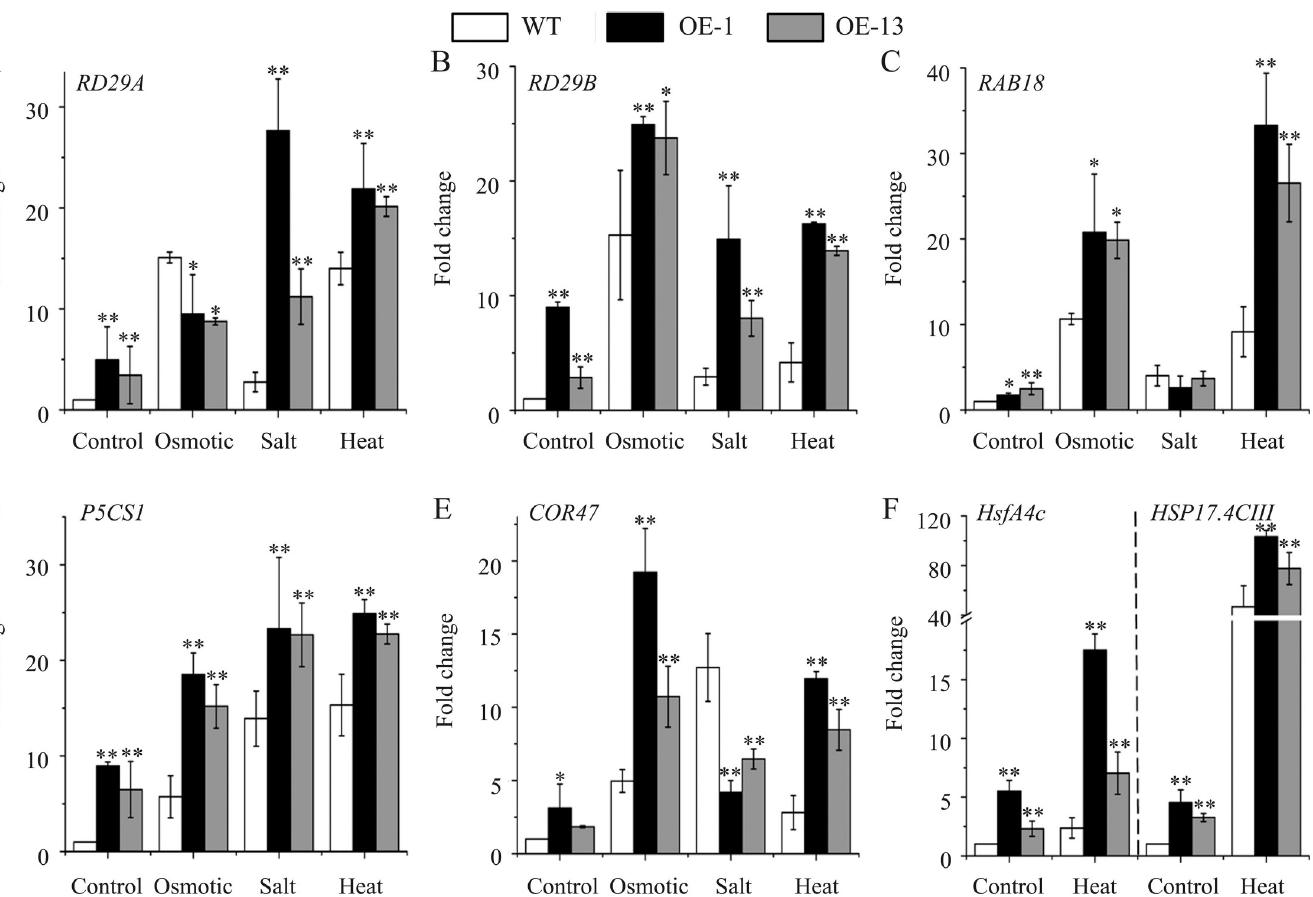
Fig 10. Transcript levels of seven stress-inducible genes in AmDREB3 transgenic Arabidopsis. The transcript levels of seven stress-inducible genes in two-week-old seedlings were examined by RT-qPCR analysis. The seedlings were exposed to osmotic stress (350 mM mannitol), salt stress (175 mM NaCl), or heat stress (37˚C) for 5 h before sampling. Asterisks and double asterisks indicate significant differences of transgenic lines (OE-1 and OE-13) compared to wild-type (WT) at p < 0.05 and < 0.01, respectively.